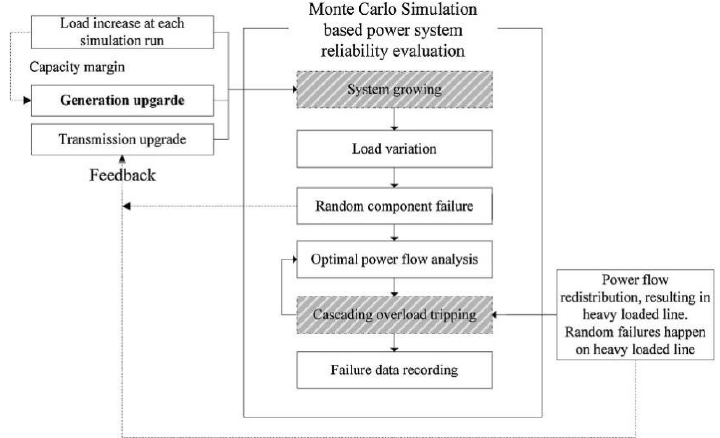
Fig. 6 Association topology diagram.